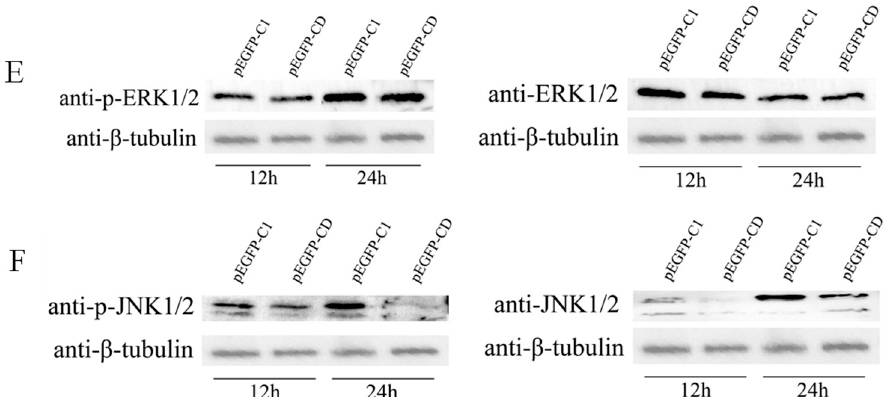
Figure 3. The effect of Ec-CD overexpression on apoptosis of fathead minnow (FHM) cells during SGIV infection. ( A ) Flow cytometry analysis of DNA content in SGIV-infected FHM cells. The percentage of the sub-G0/G1 phase was calculated and is indicated on the histogram. ( B ) The level of cleaved caspase-3 proteins was detected by WB, and cleaved caspase-3/ β -tubulin for each group was calculated as above ( C ). ( D ) The activities of caspase-3, caspase-8 and caspase-9 were examined in SGIV-infected FHM. Date are expressed as a ratio to the caspase activity of cells transfected with pEGFP-C1 at 12 h. Data are means ± SD from four experiments. Student’s t -test: * p < 0.05. ( E ) Detection of ERK1/2 phosphorylation and ( F ) JNK1/2 phosphorylation expression during SGIV infection by WB. Cell lysates from SGIV-infected FHM cells transfected with pEGFP-C1 or pEGFP- CD were collected at the indicated times and subjected to WB. To verify equal loading, Western blotting was performed with antibody against β -tubulin, ERK1/2, JNK, phospho-ERK1/2, and phospho-SAPK/JNK.